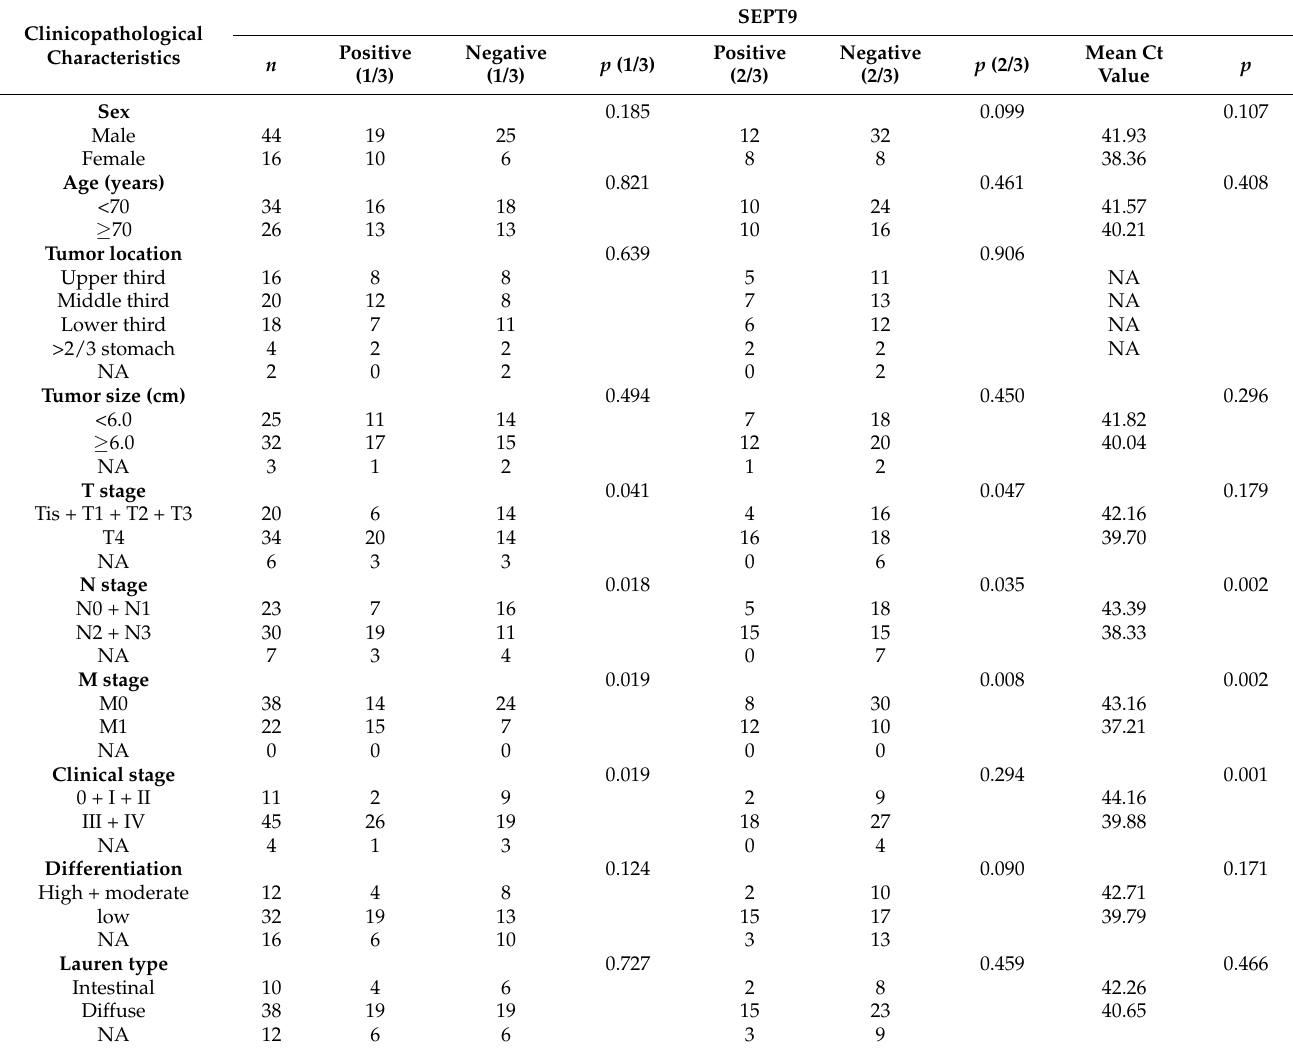
Table 5. Correlations between mSEPT9 and the clinicopathologic characteristics of the GC